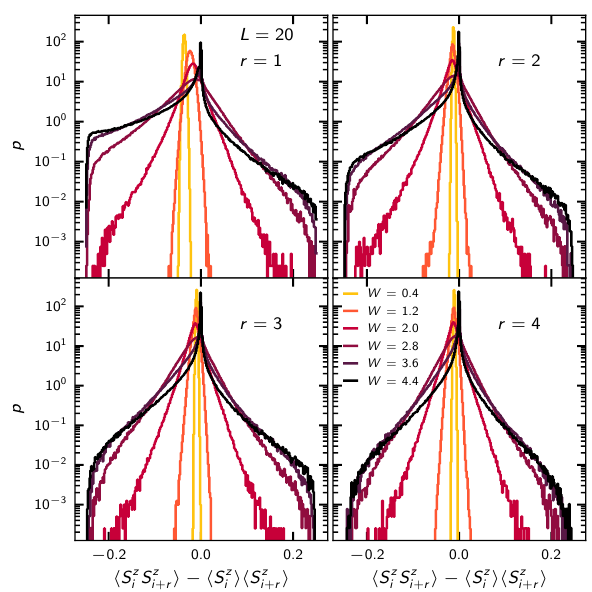
〉 S z in en- c i i + r